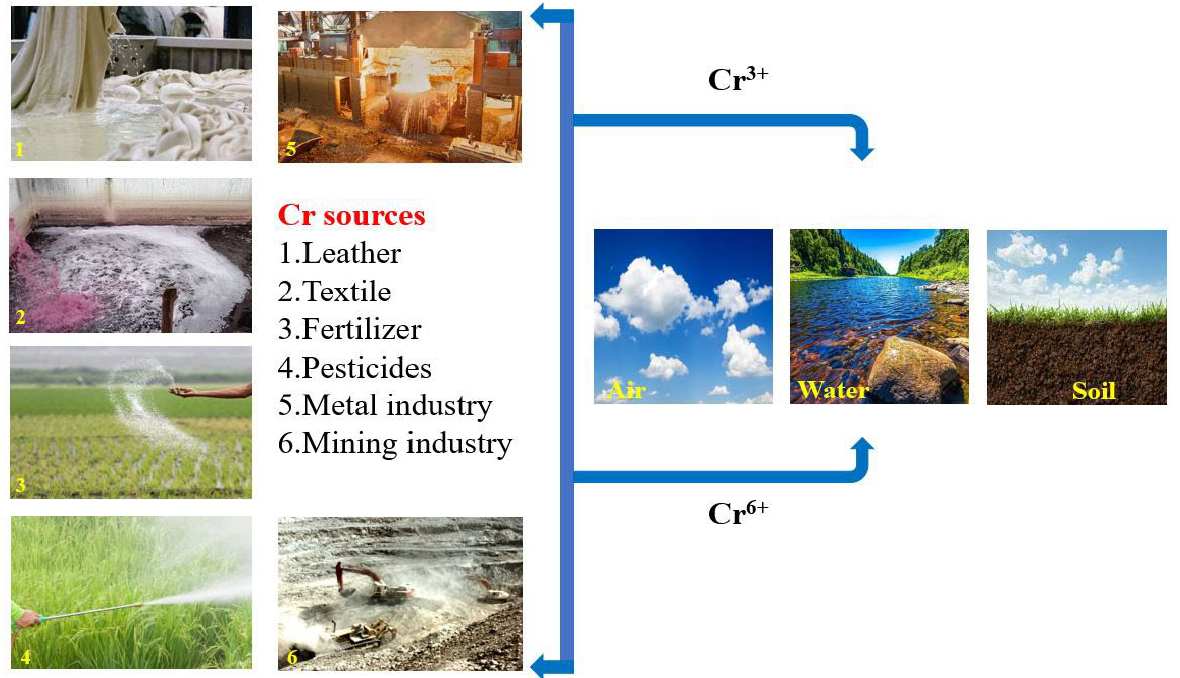
Figure 3. Exposure of chromium.